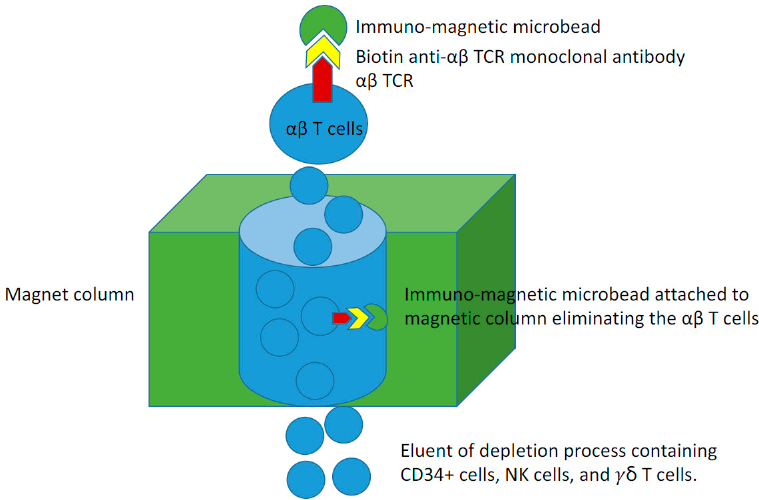
Figure 3. Immuno-magnetic microbead depletion process of the αβ T cells.